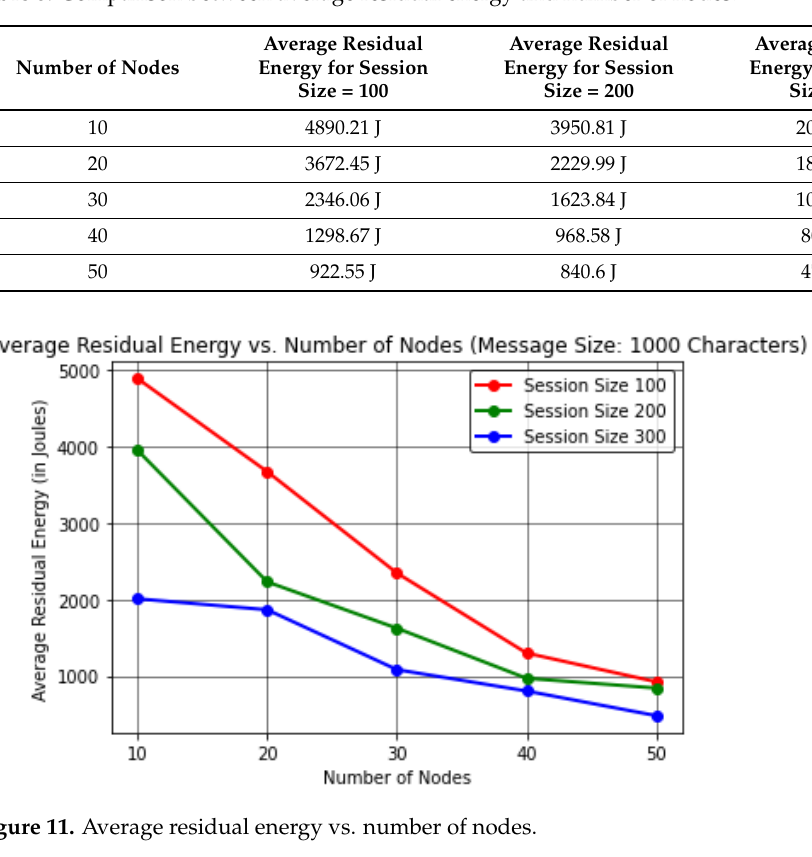
Table 8. Comparison between average residual energy and number of nodes.